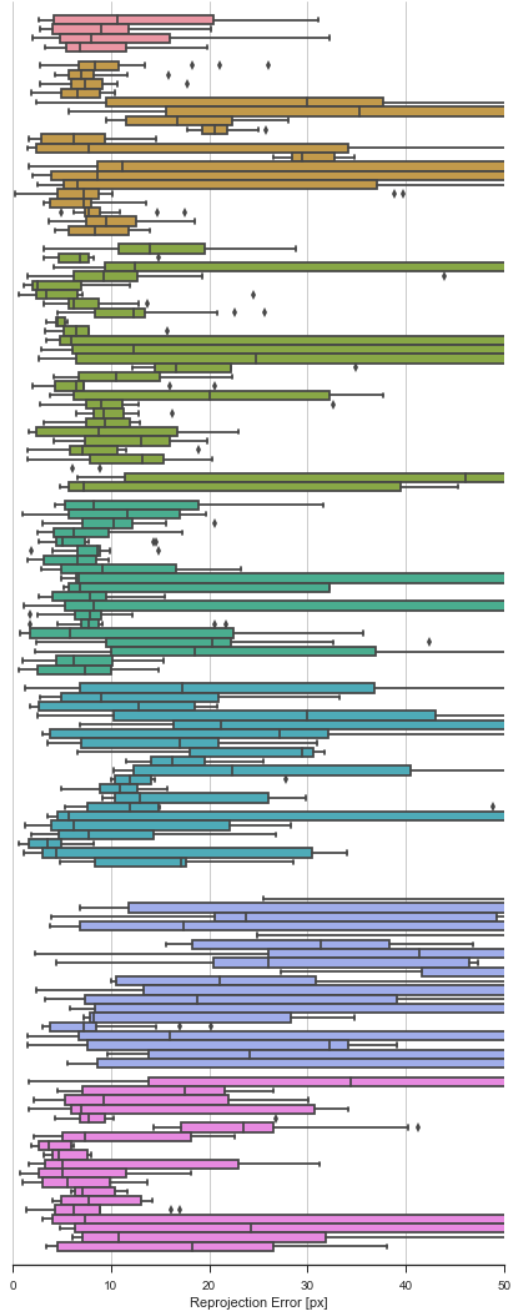
Figure 6. Boxplots for reprojection errors of check points in our outdoor scene. Each location is indicated by a different colour, from 101 on top to 107 on bottom. X axis is cut off at 50 pixels to prevent extreme distortion due to